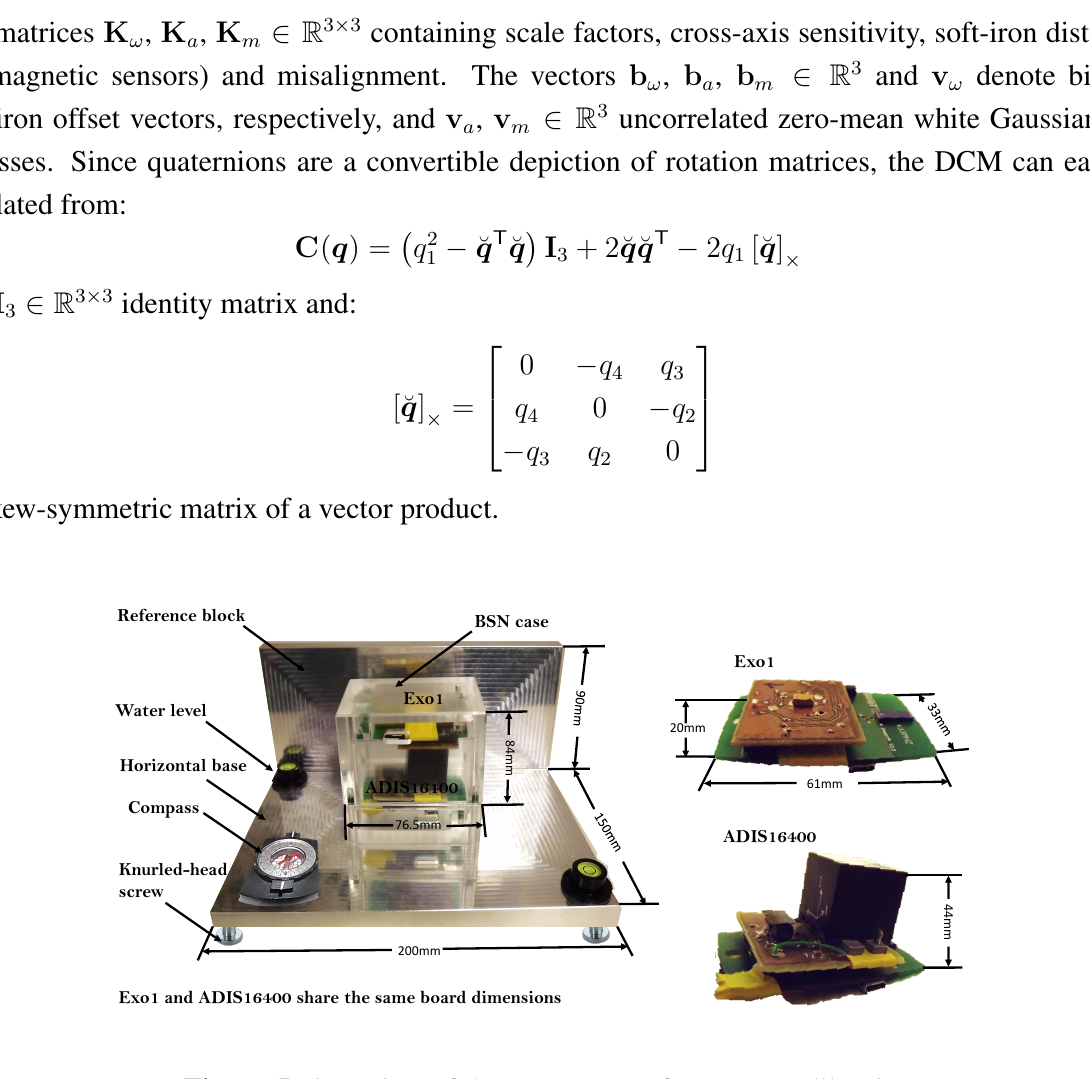
Figure 5. Overview of the components for sensor